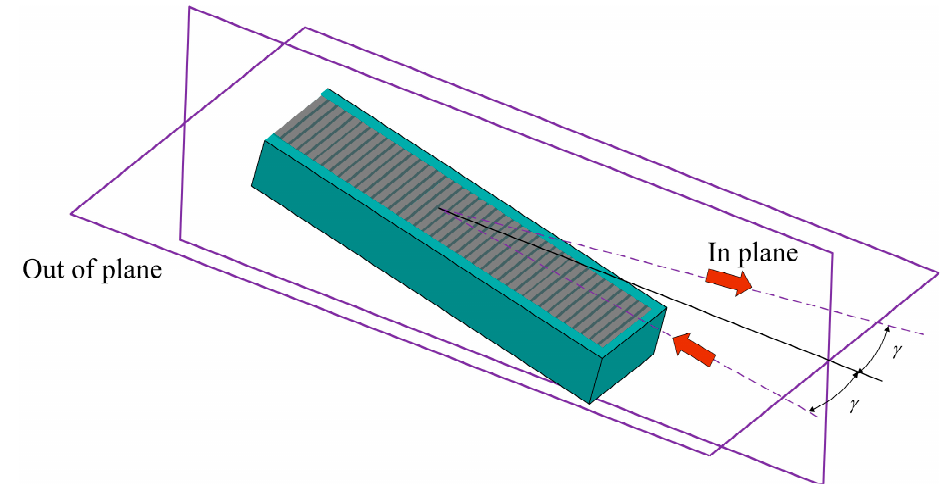
Figure 3. Schematic of echelle optics in quasi-Littrow configuration.